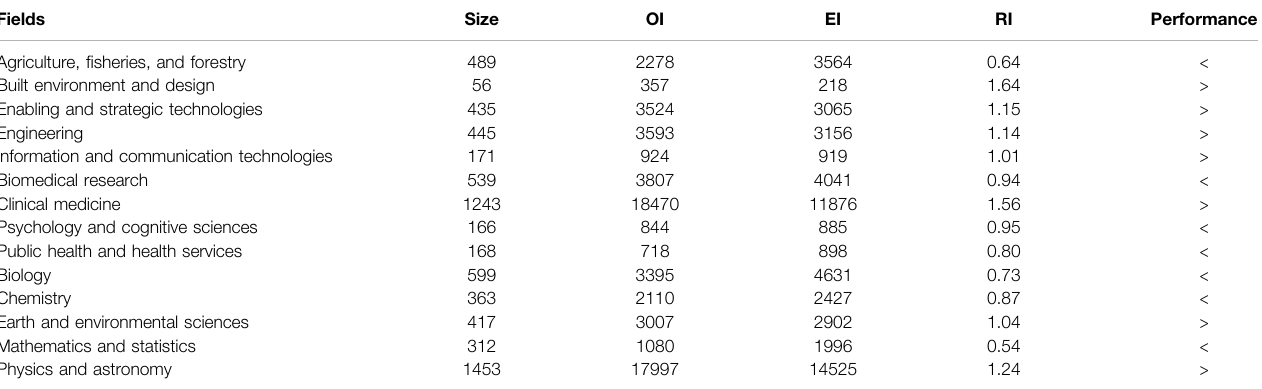
TABLE 5 | The observed, expected, and relative impact of the Chilean science system.